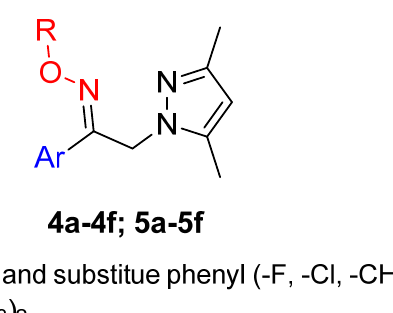
Figure 5. Chemical structure of the designed compounds ( 4a - 4f ; 5a - 5f